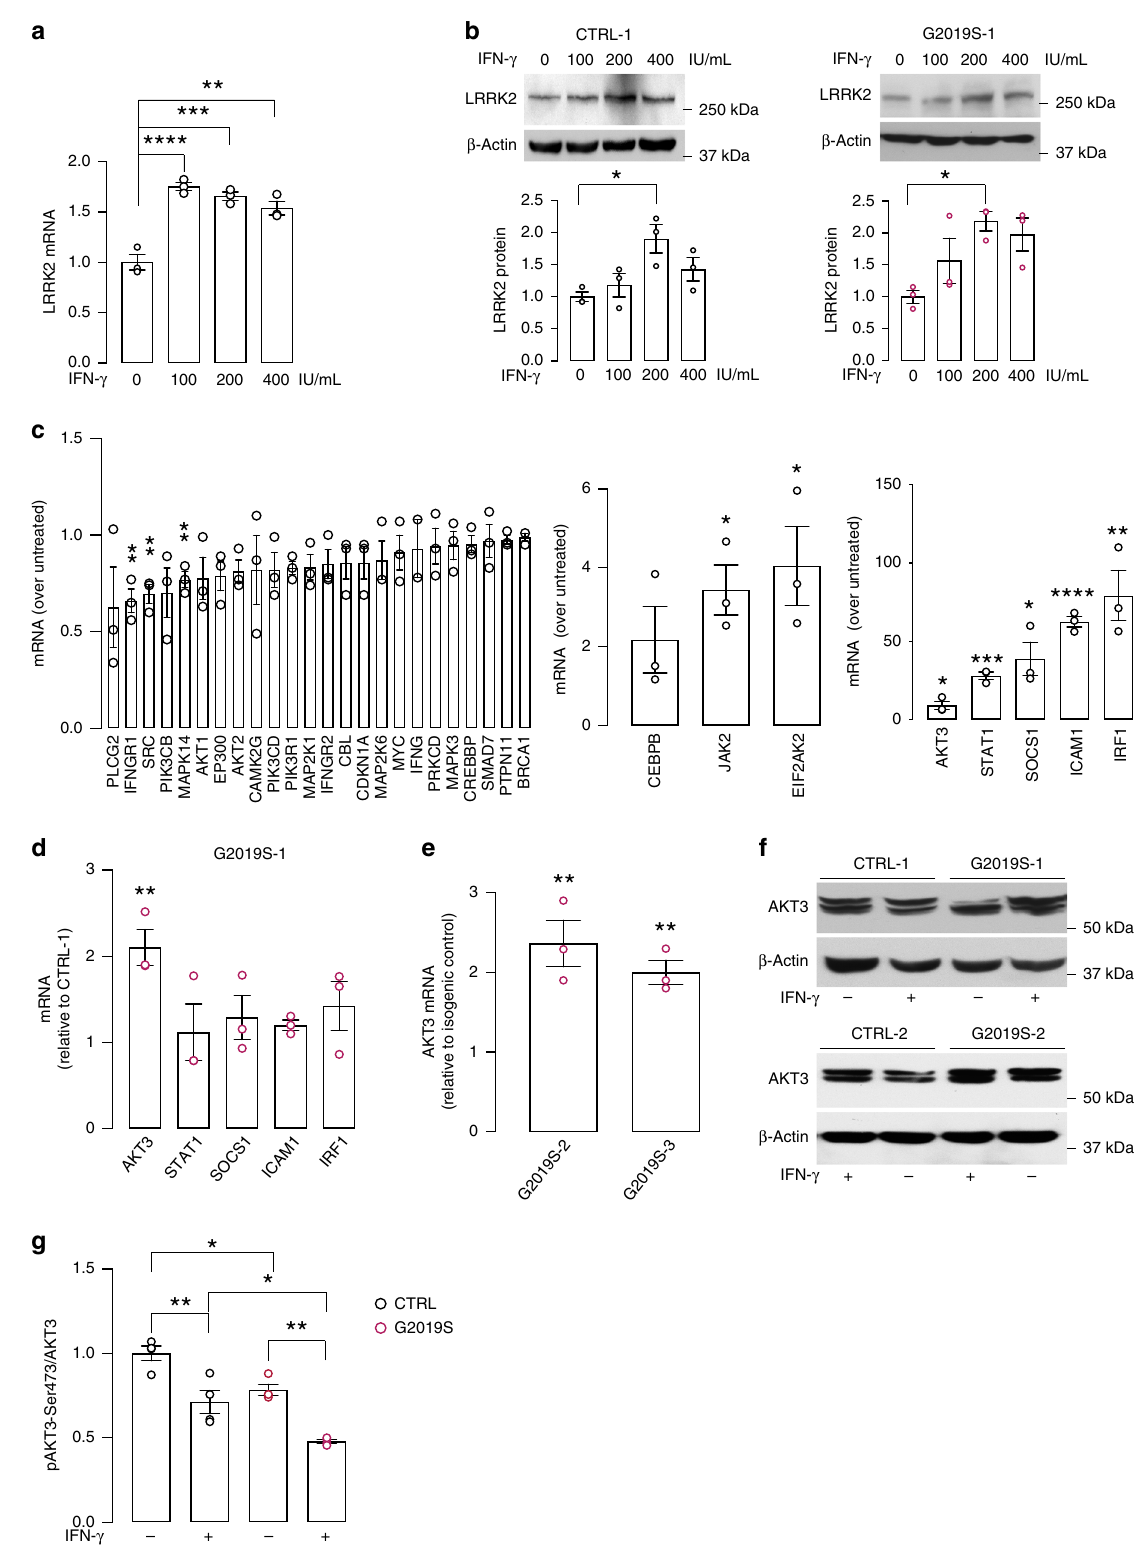
LRRK2 G2019S and control neurons, with the strongest effect observed in LRRK2 G2019S neurons (38.9% reduction, compared to 28.8% in control neurons) (Fig. 1g). To con fi rm this result, and to determine whether all AKT isoforms are similarly regulated by LRRK2 and IFN- γ , we performed Western blotting using a pan-AKT antibody. In line with our phospho-AKT3 data,